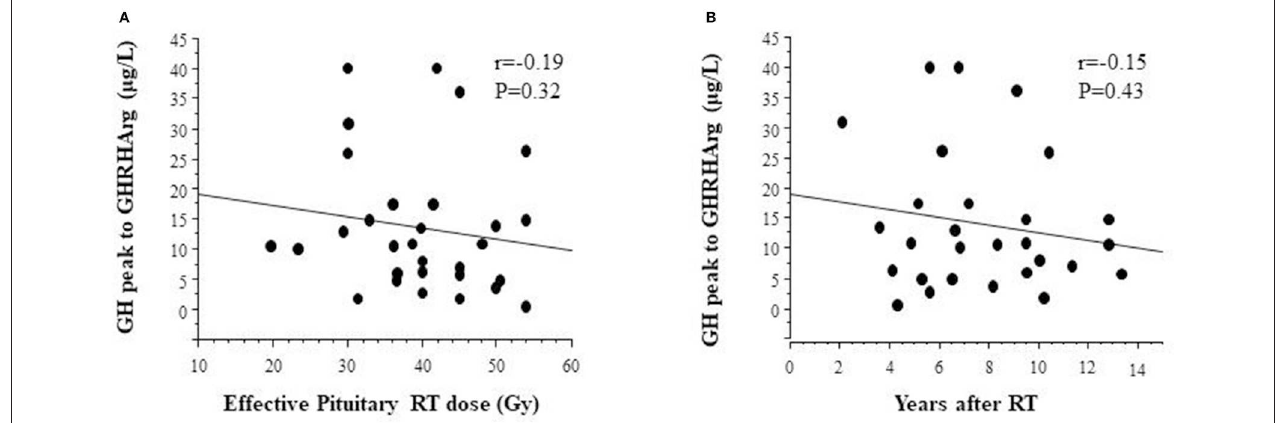
FIGURE 4 | Relationship between GH peak responses to GHRHarg and (A) effective radiotherapy dose, and (B) distance (years) after